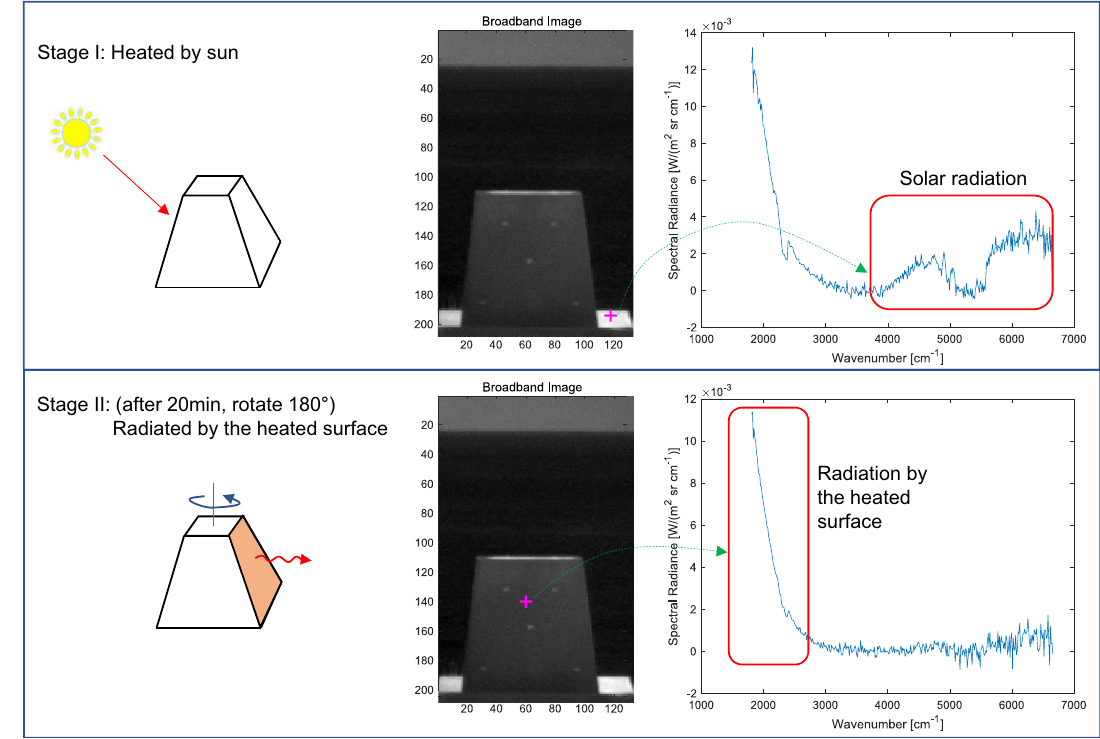
Figure 6. Thermal stealth evaluation flow caused by solar radiation at day